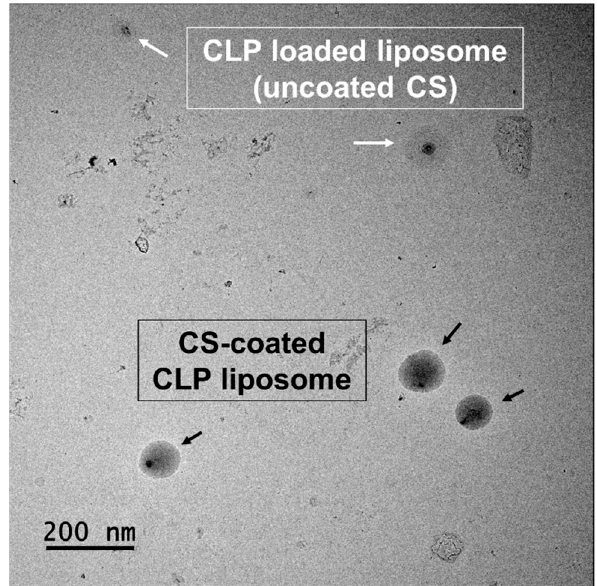
Figure 2. TEM image of CLP-loaded liposomes and CS-coated CLP liposomes (magnification = 25,000×).